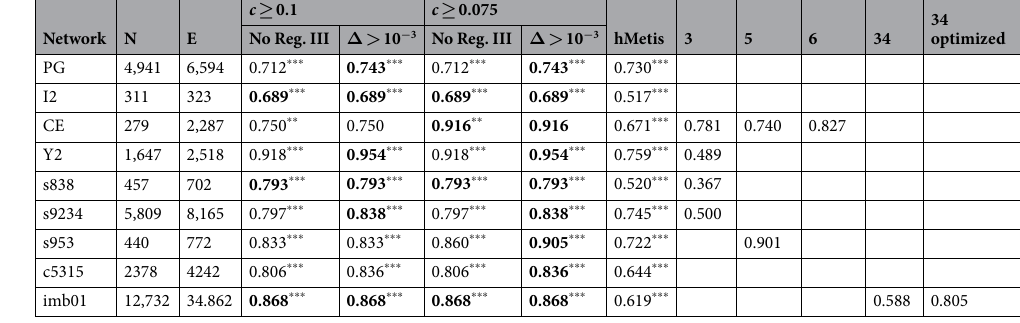
Table 1. Rent exponents for different partitioning algorithms and different thresholds compared with values obtained by other authors 3, 5, 6, 34 . The order and size of each network is also reported. Rent exponents obtained using regression with the best coefficient of determination are in bold. Significance levels of 1% and 5% are marked with ( *** ) and ( ** ) respectively when using box counting method. The p -values are given in Supplementary Information (see Table S1).